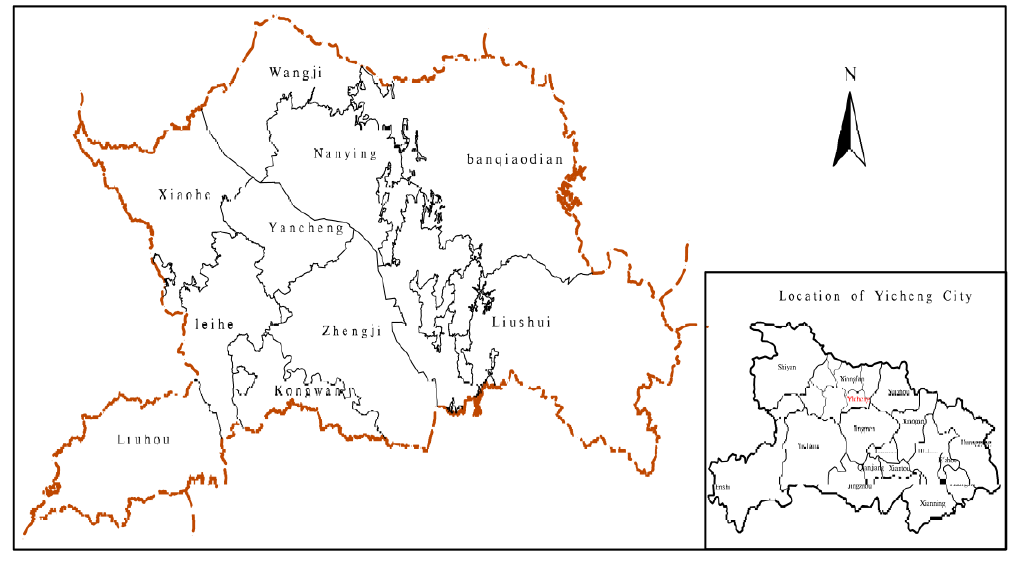
Figure 1. Location of the study